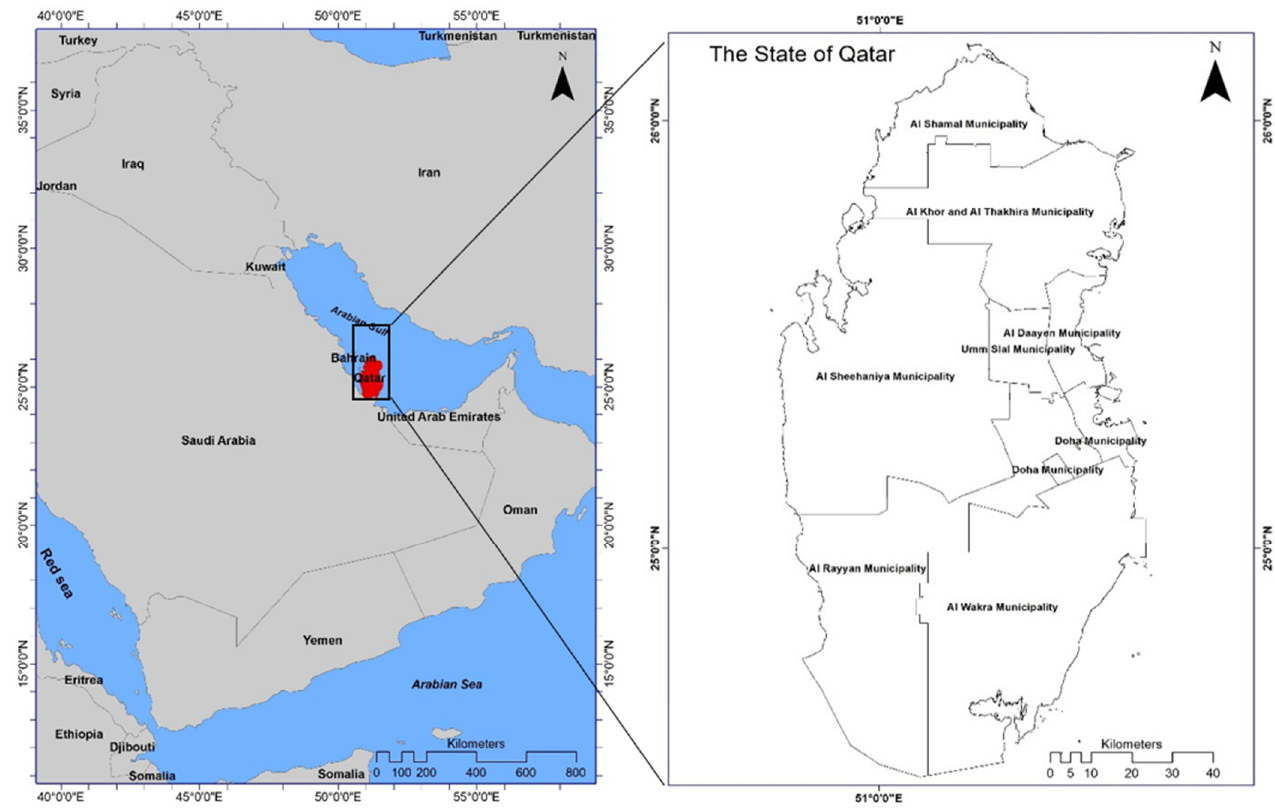
Figure 1. Map showing the location of Qatar [54].